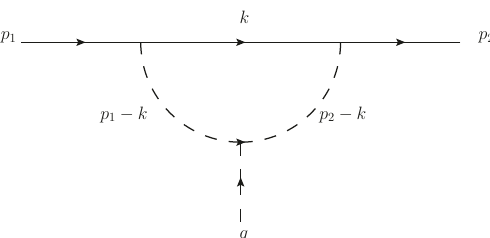
Figure 18. Feynman diagram for loop induced h- ψ - ψ coupling. Internal scalar lines are from propagating pseudo-scalar, a